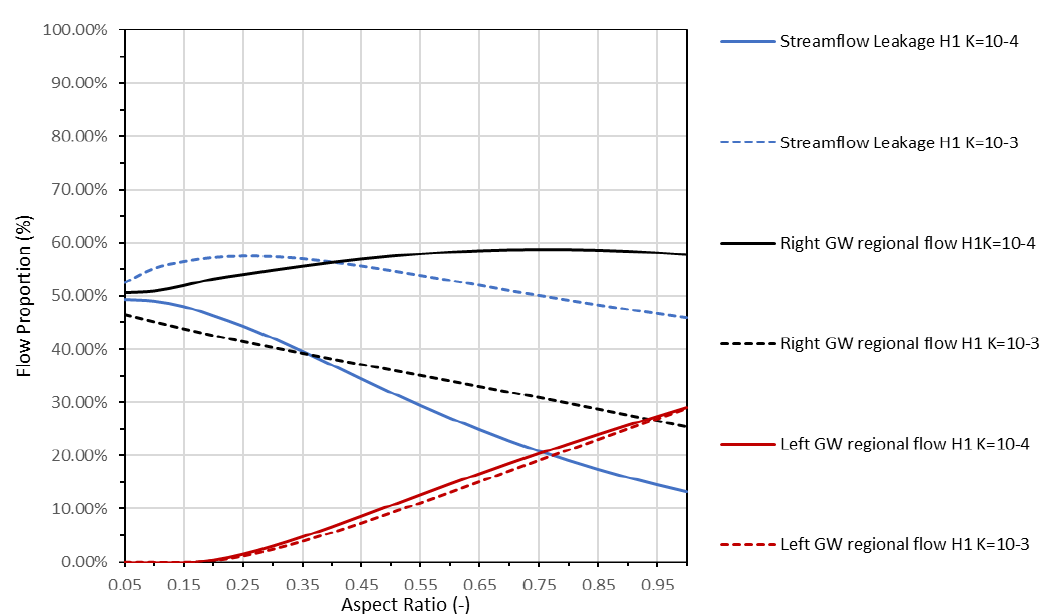
Figure A2. Evolution of the proportion of water in the pumping well with the aspect ratio for the hydraulic head gradient condition H1 and for a hydraulic conductivity of 10 −3 m s −1 (Sim$2.3) and 10 −4 m s −1 .